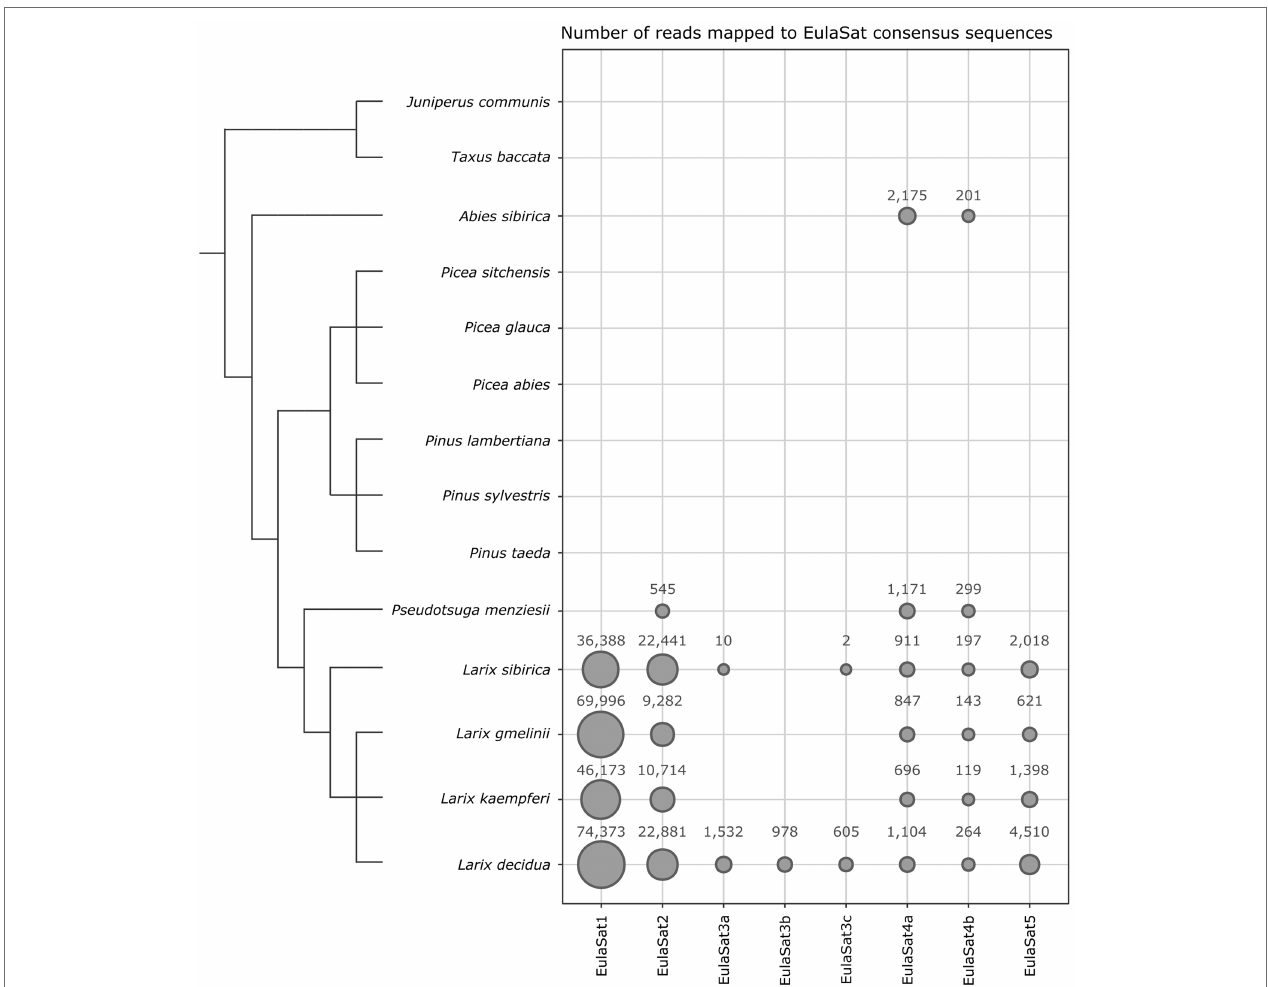
FIGURE 5 | Distribution of the EulaSat tandem repeats in fourteen gymnosperm genomes surveyed by read mapping. The area of each bubble represents the amount of whole genome shotgun Illumina reads mapping to the EulaSat consensus sequences. A total of three million paired reads have been used as input for the mapping analysis. The dendrogram indicates the evolutionary relationship between the species according to Wei and Wang (2003) for the genus Larix and Lu et al. (2014) for the overall phylogeny. The branch lengths are not to